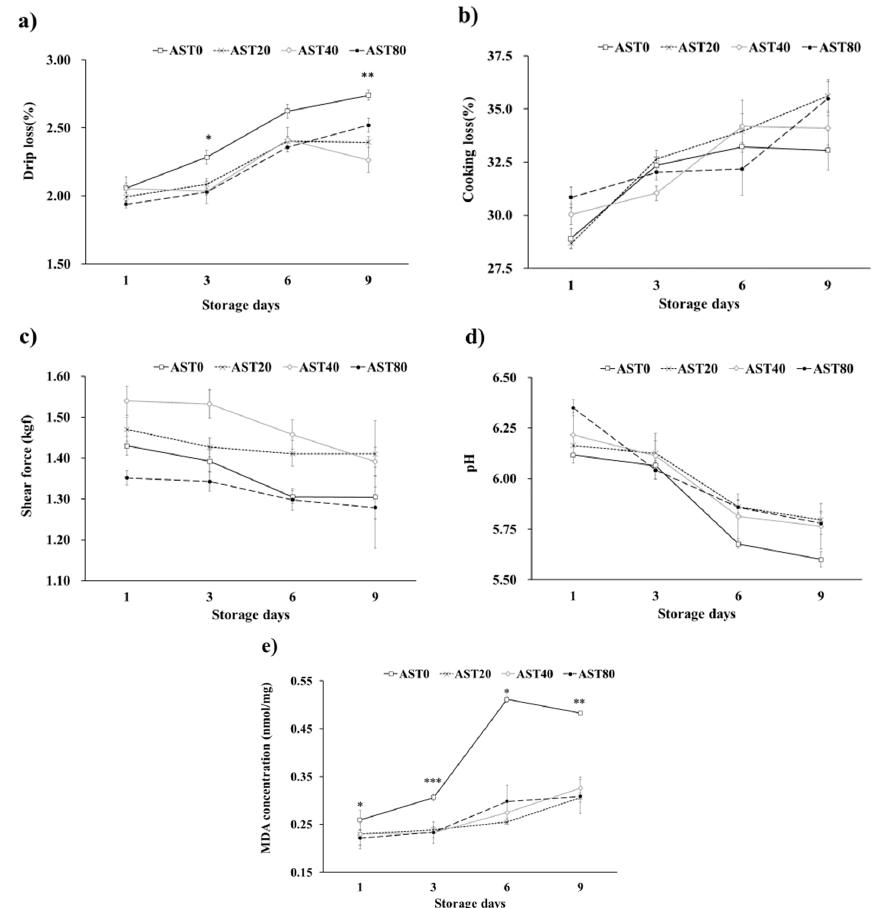
Figure 2. Effect of dietary astaxanthin supplementation levels on drip loss ( a ), cooking loss ( b ), shear force ( c ), pH ( d ), and malondialdehyde (MDA) concentration ( e ) in the leg muscle of broilers at 4 °C. AST0, basal diet; AST20, basal diet + 20ppm astaxanthin; AST40, basal diet + 40ppm astaxanthin; AST80, basal diet + 80ppm astaxanthin; *, p < 0.05; ** p < 0.01; ***, p < 0.001.